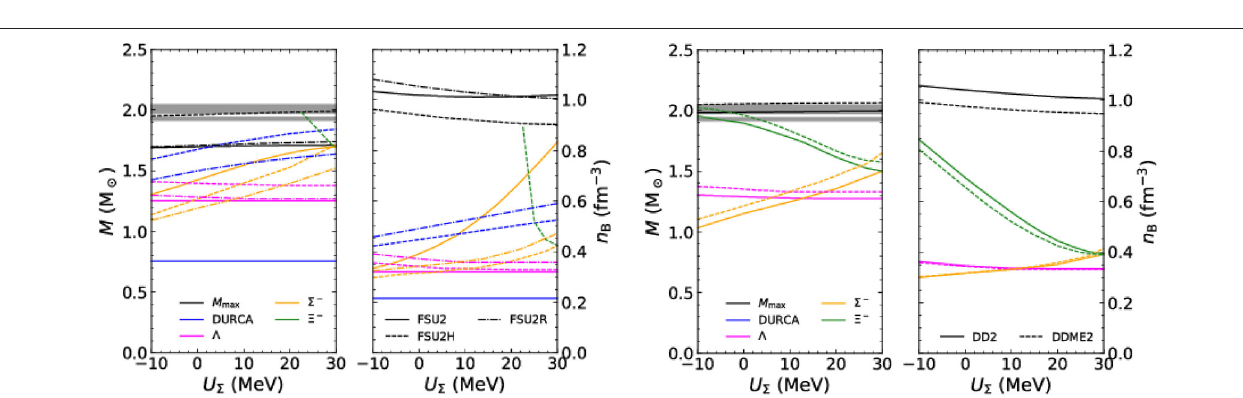
FIGURE 8 | The same as in Figure 7 for the models FSU2, FSU2R, and FSU2H (Left) and DD2, DDME2 (Right)